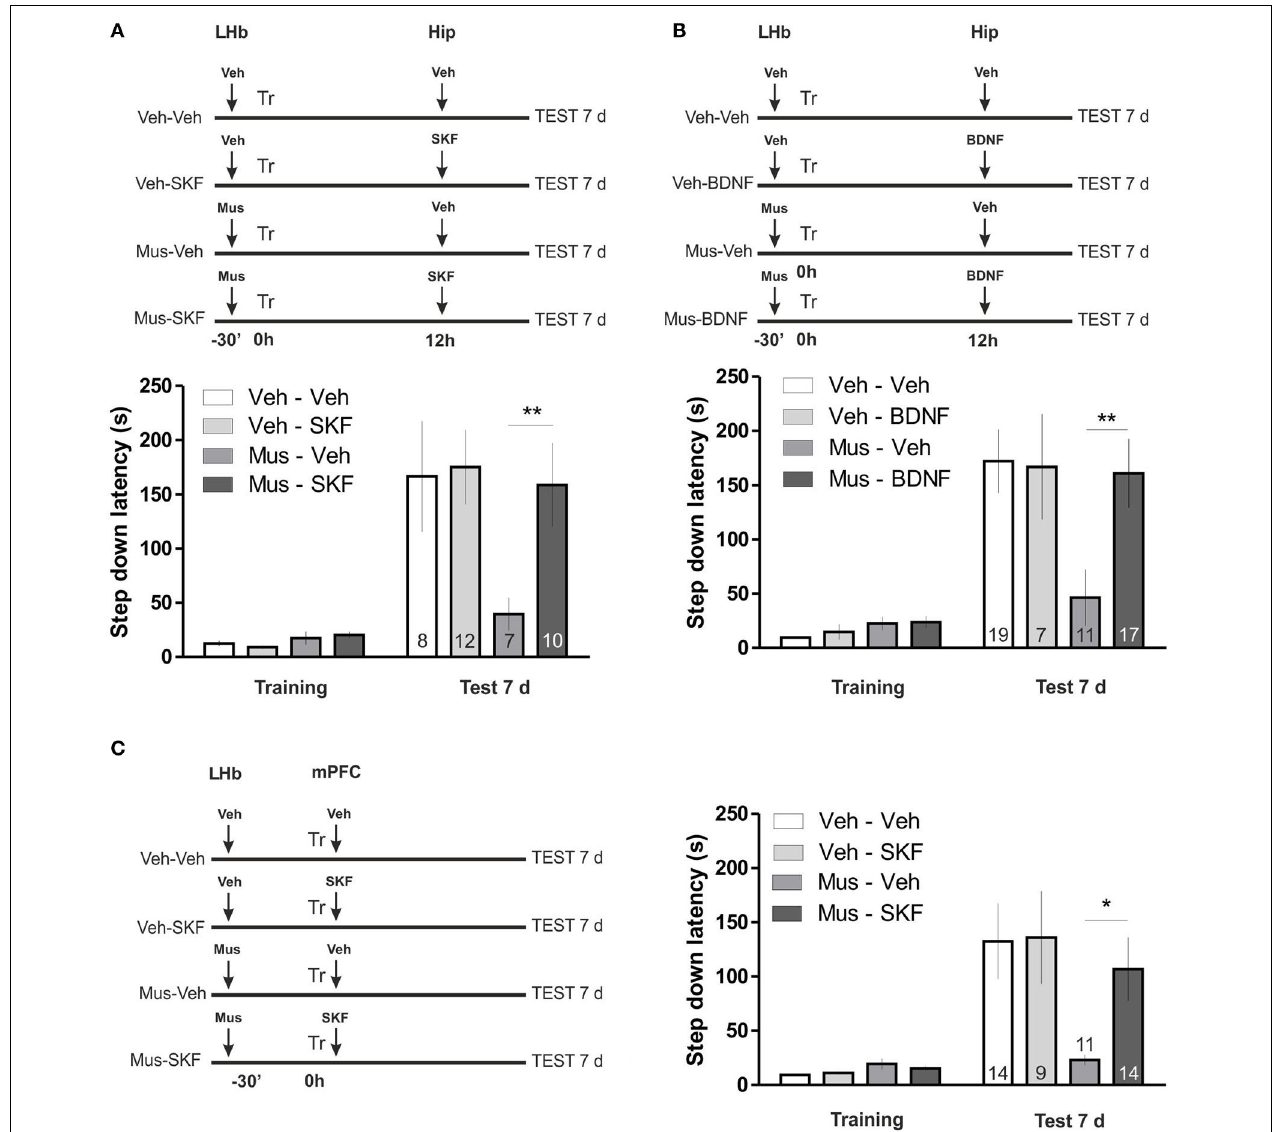
FIGURE 2 | (A) Activation of D1/D5 receptors in the hippocampus 12h after training reverses memory maintenance deficits induced by LHb inactivation. Top: diagram illustrating the protocol used. Bottom: hippocampal infusion of SKF-38393 12h after training reversed memory deficits induced by inhibition of the LHb during training. (B) BDNF in the hippocampus 12h after training reverses memory maintenance deficits induced by LHb inactivation. Top: diagram illustrating the